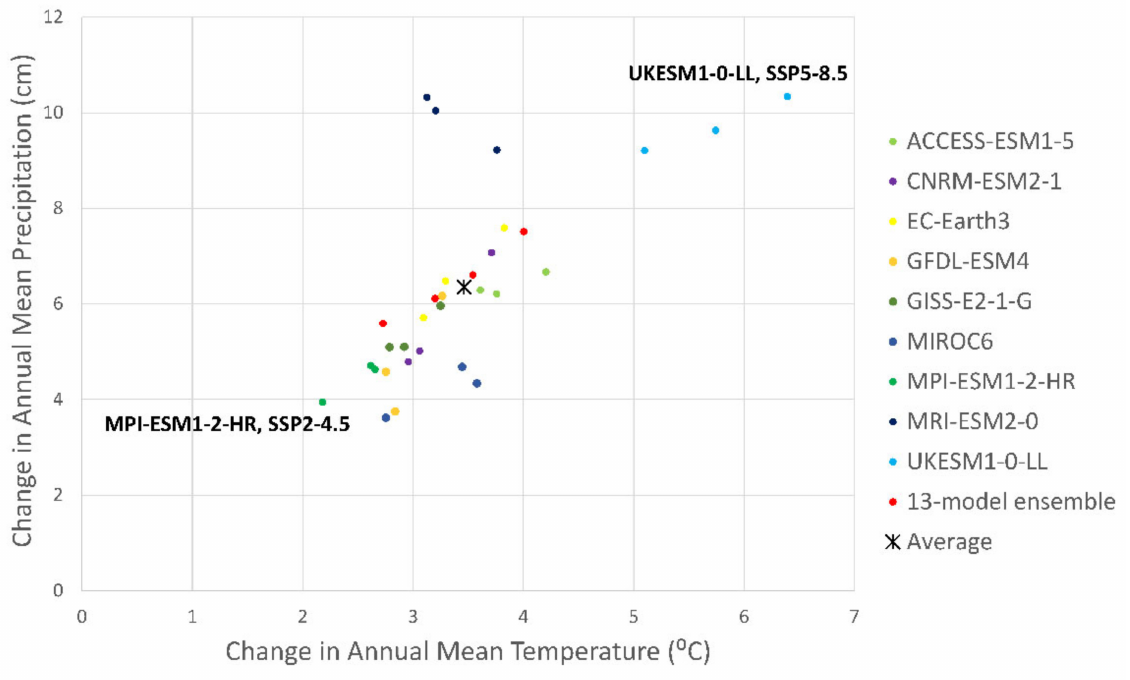
Figure 3. Spread of climate futures projected with 9 individual AOGCM and a 13-model ensemble using 4 CMIP6 emission scenarios (SSP1-2.6, SSP2-4.5, SSP3-7.0, SSP5-8.5). Change in average annual mean temperature and average annual total precipitation for the 2040–2071 projection relative to the 1961–1990 historical period for the Tetlin National Wildlife Refuge. The average represents 31 projections: 9 AOGCMs × 3 emission scenarios (SSP1-2.6, SSP3-7.0, SSP5-8.5) and the 13-model ensemble × 4 emission scenarios (SSP1-2.6, SSP3-7.0, SSP5-8.5). The least warm and wet (MPI- ESM1-2-HR, SSP2-4.5) and the most warm and wet (UKESM1-0-LL, SSP5-8.5) projection extremes are